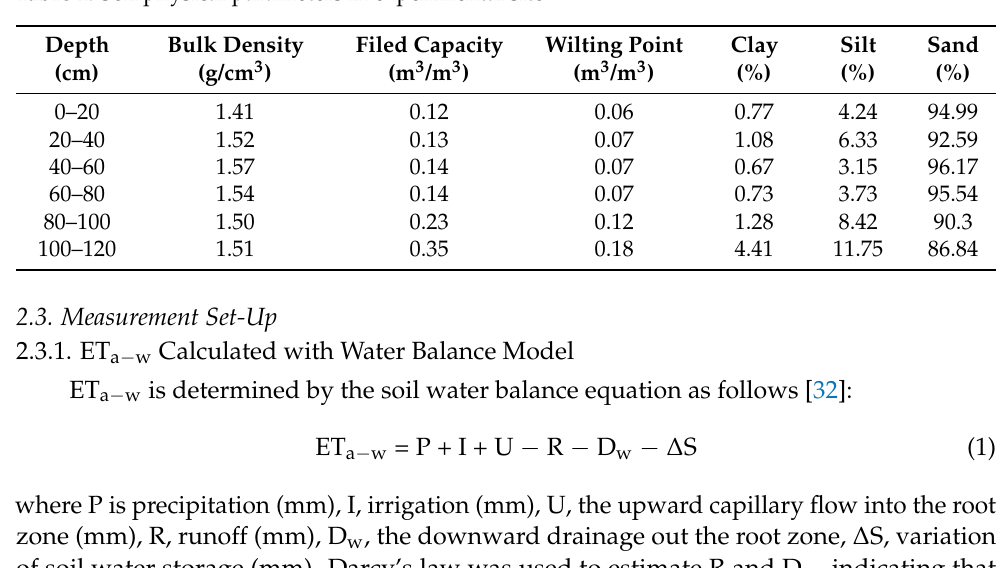
Figure 2. Meteorological data in ( a ) 2019 and ( b ) 2020. Table 1. Soil physical parameters in experimental site.